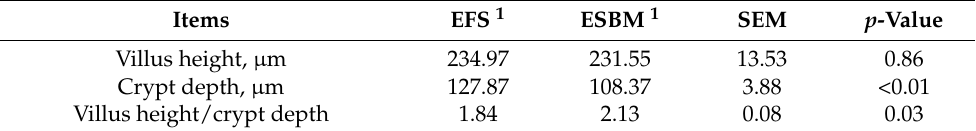
Table 6. Effects of enzyme-treated soybean meal replacing extruded full-fat soybean on intestinal morphology in nursery pigs Table 6. Cont.